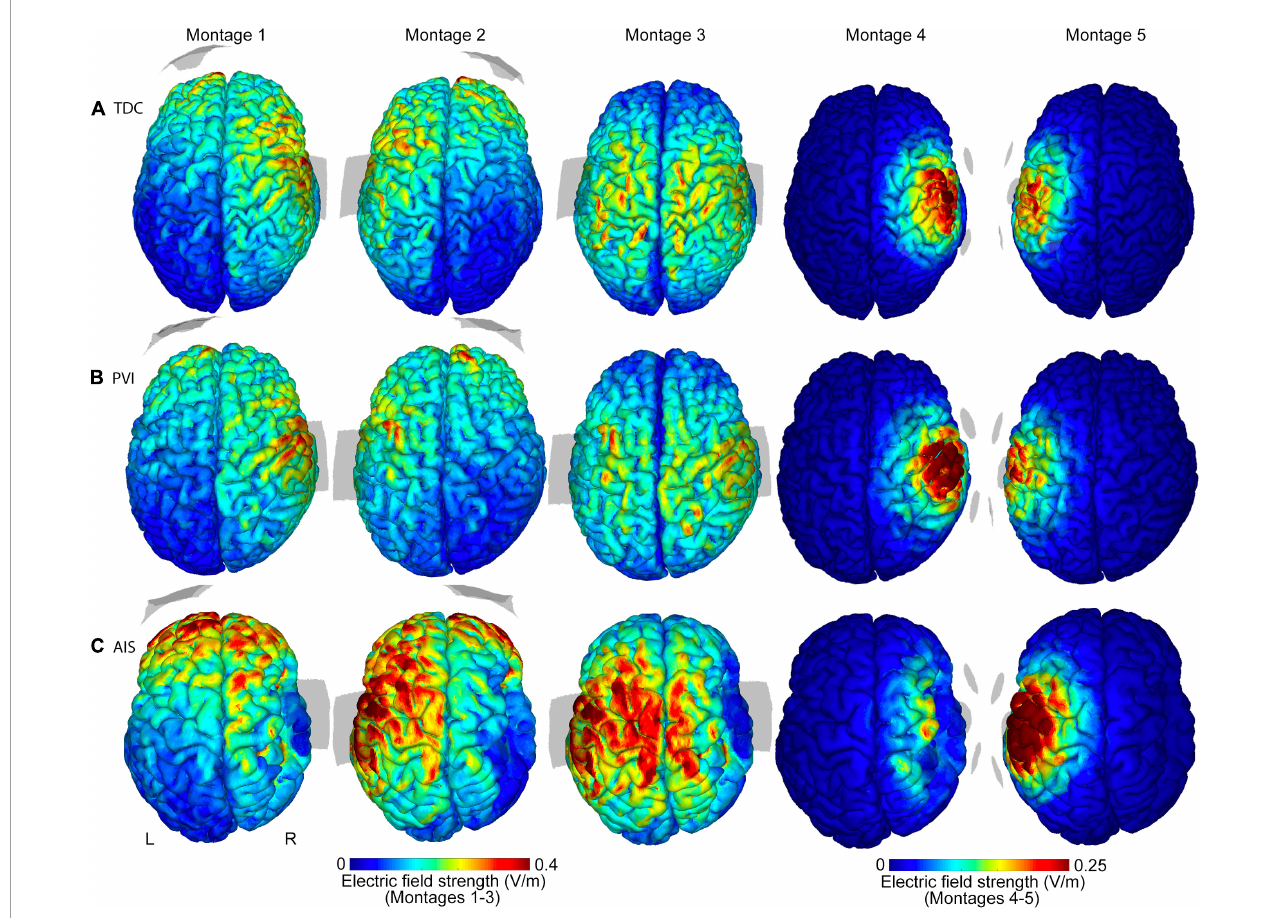
FIGURE2 Illustrations of electric field (EF) strength distributions on the gray matter surface for five transcranial direct-current stimulation (tDCS) montages. Shown are three individual participants of similar ages (15.6 y, 14.4 y, and 15.0 y, respectively) from the (A) TDC, (B) PVI, and (C) AIS groups. T1-weighted anatomy is also illustrated in Figure 1 for the same participants. Stroke participants have a right hemisphere stroke. Note that the EF strength scales are the same for each participant group but are different between montages 1–3 and montages 4–5. Gray shaded areas represent electrode placements. TDC, typically developing control; PVI, periventricular infarction; AIS, arterial ischemic